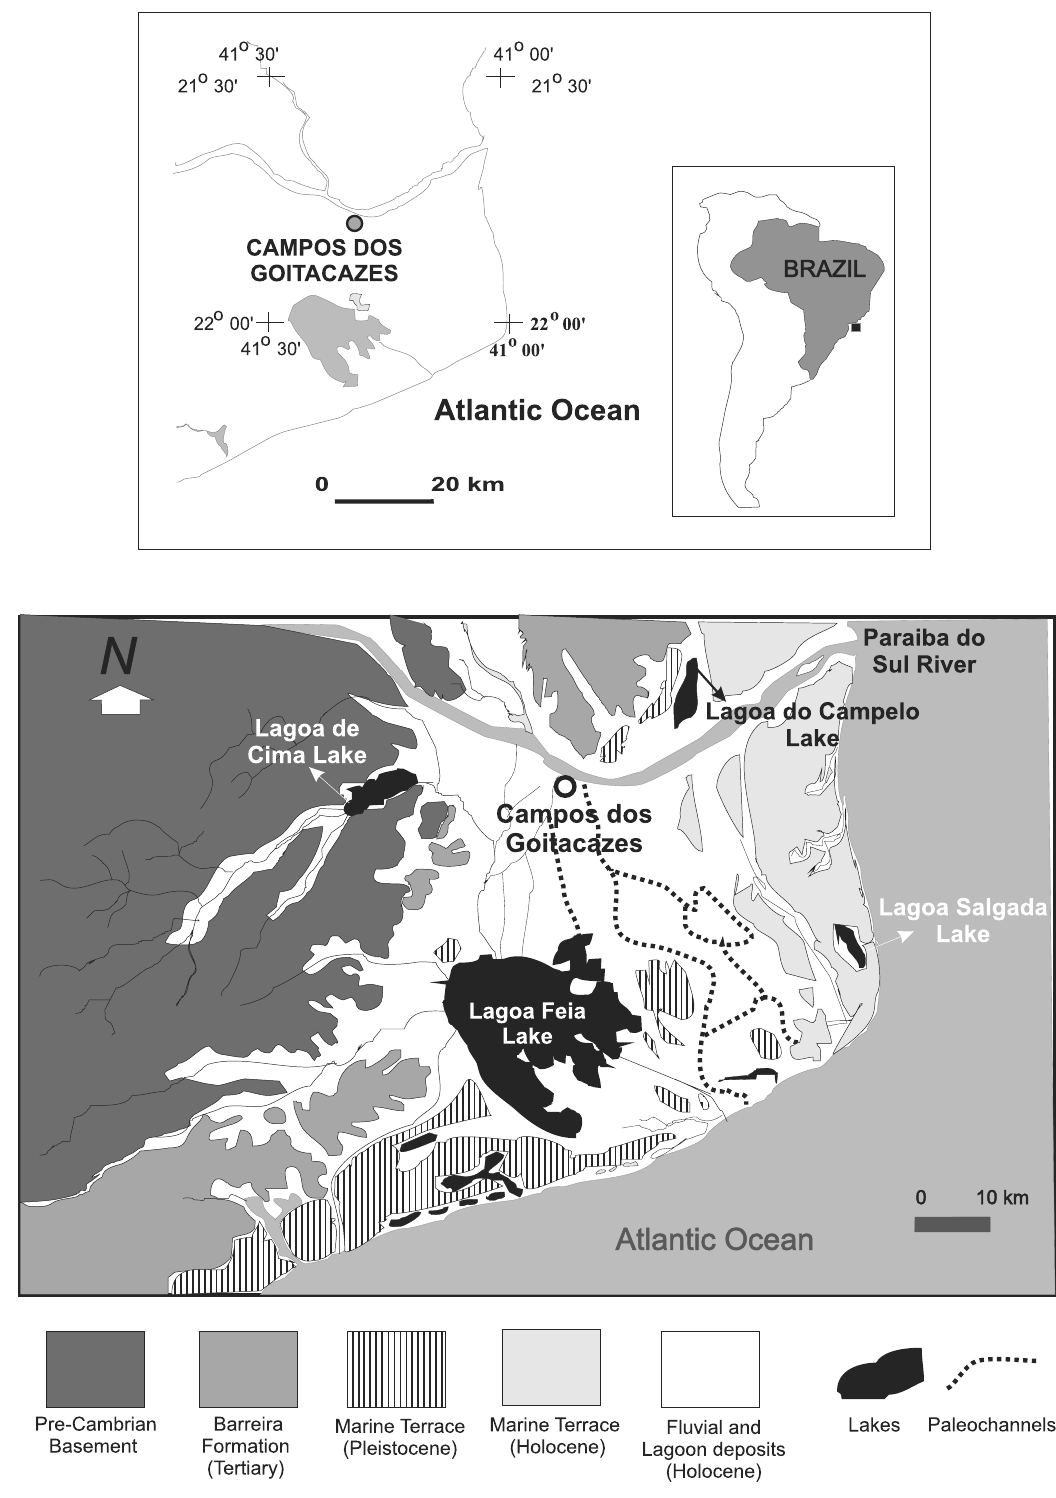
Fig. 1 – Geological map of the deltaic plain of the Paraíba do Sul River and location of the Lagoa de Cima and Lagoa do Campelo Lakes, Campos dos Goitacazes municipality (Martin et al. 1993,